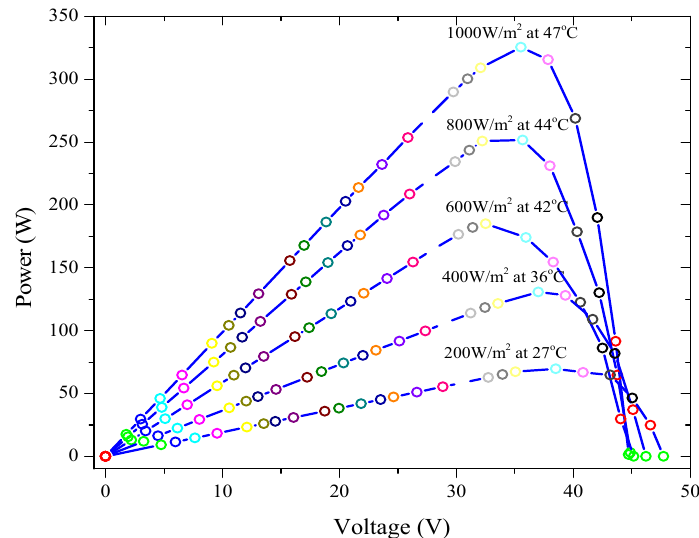
Figure 18. I–V curves of the measured and the calculated currents for the double-diode practical system at different irradiance and temperature levels.